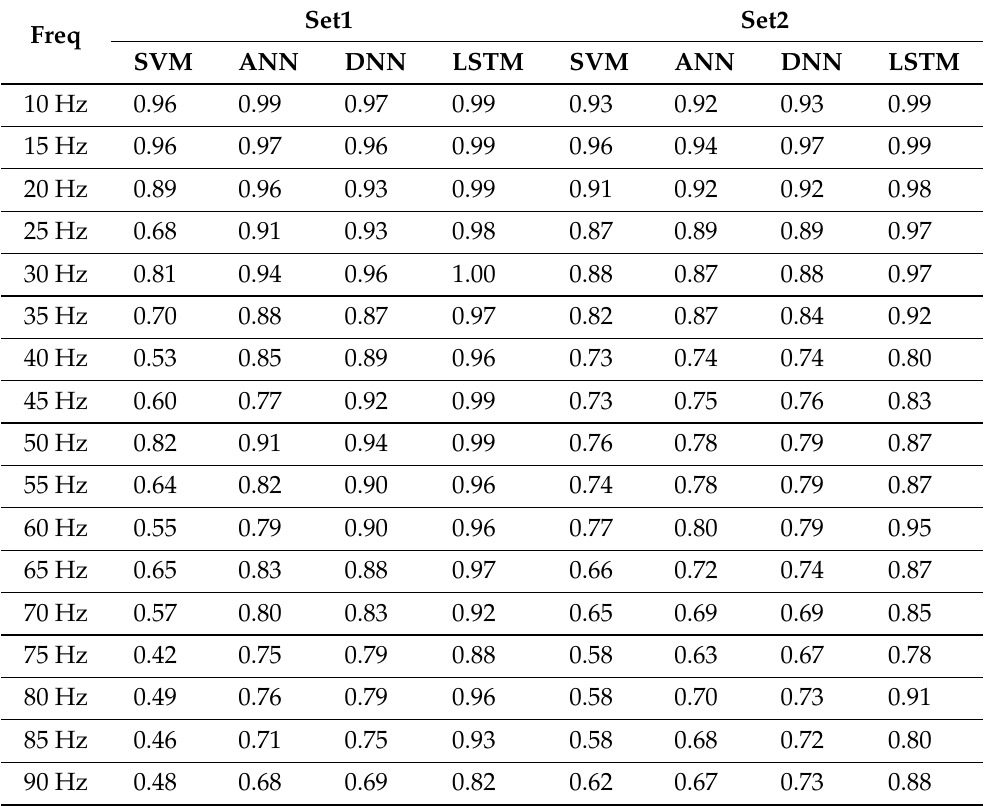
Table 2. Experimental results of the proposed model and conventional model about each frequency of the ES. Abbreviations; Frequency